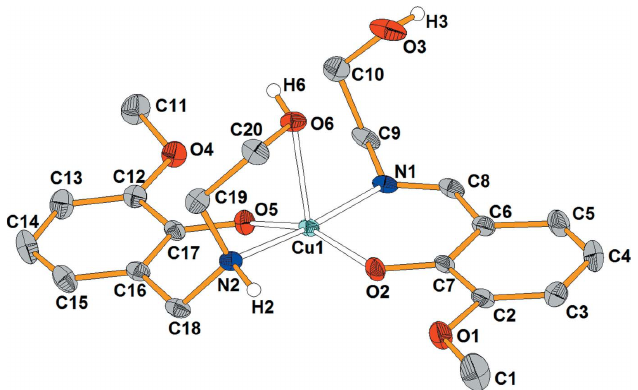
Figure 1 Molecular structure of (I), with the numbering scheme and displacement ellipsoids drawn at the 50% probability level (carbon-bound H atoms are omitted for